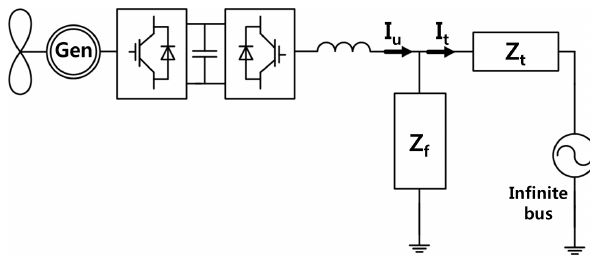
Figure 3. Configuration of the full converter-type WT for calculating the restoration